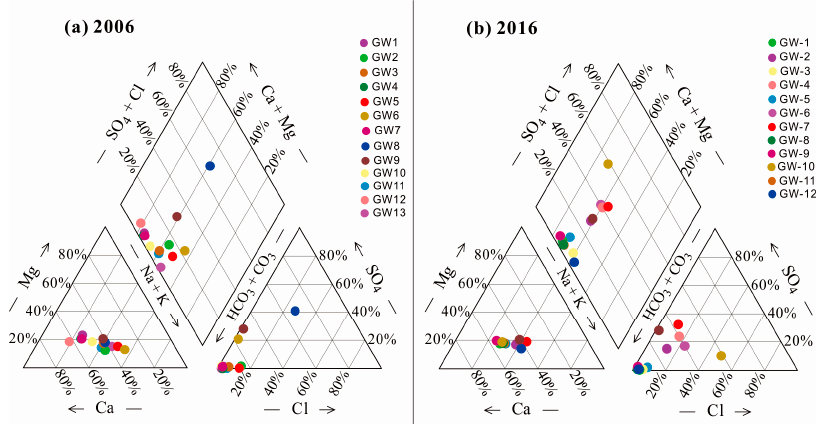
Figure 2. Piper diagrams for the groundwater major ions in 2006 ( a ) and 2016 ( b ).